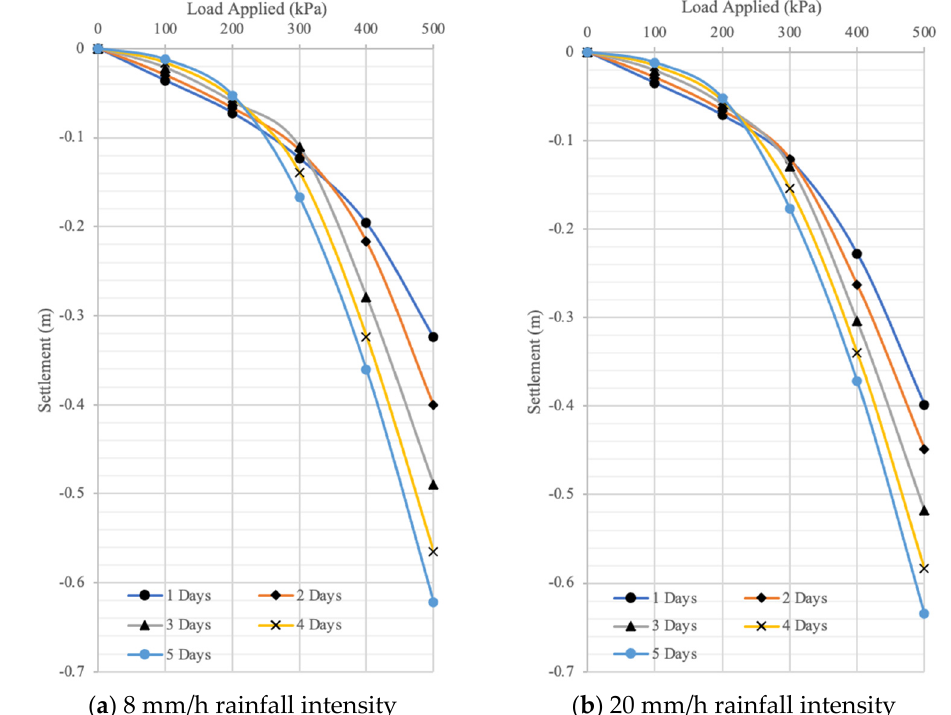
Figure 8 . Load–settlement curves (groundwater table 5 m below).